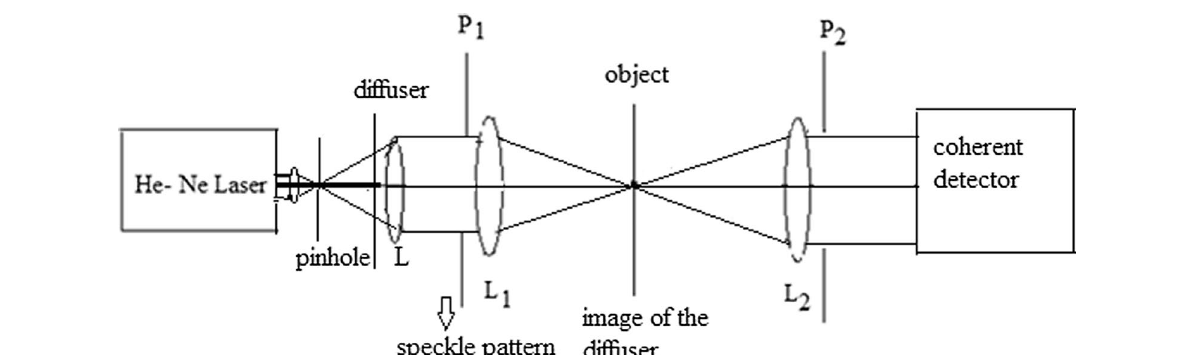
Fig. 1 Confocal microscopic imaging of non‑scanned object using a diffuser placed in front of the lens L . The two microscope objectives are L 1 and L 2 . The image of the diffuser spreads over the object in its